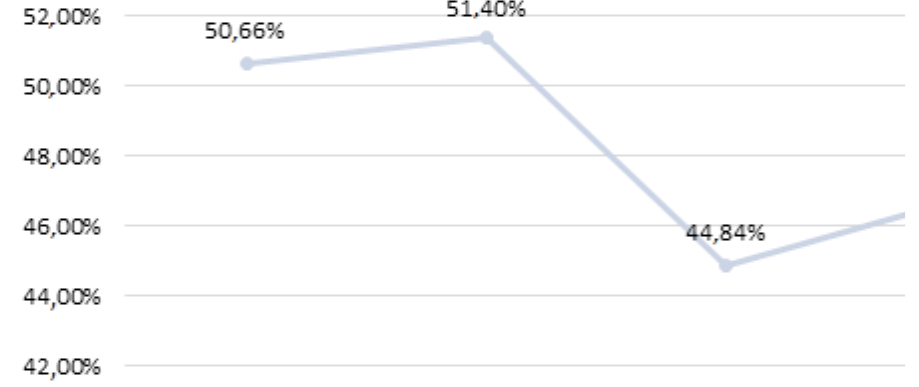
Figure 6. Short-term indebtedness of SMEs financed in the